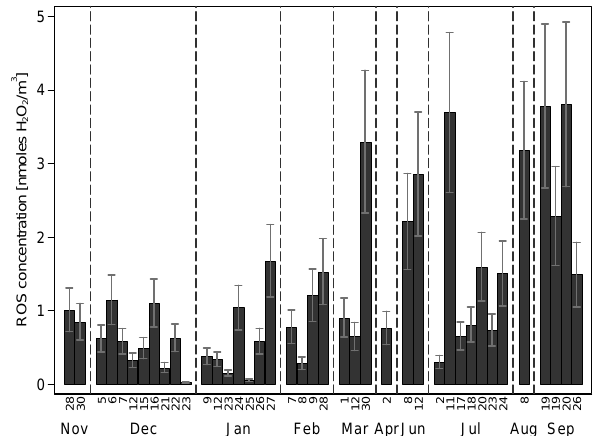
Figure 1: Concentration of ROS on PM 2.5 sampled at an outdoor location away from point 3 Figure 1. Concentration of ROS on PM 2 . 5 sampled at an outdoor sources in Austin, Texas. The error bars represent the average standard error of replicate samples 4 location away from point sources in Austin, Texas. The error bars taken on 20 of the 40 sampling days. 5 represent the average standard error of replicate samples taken on 20 of the 40 sampling